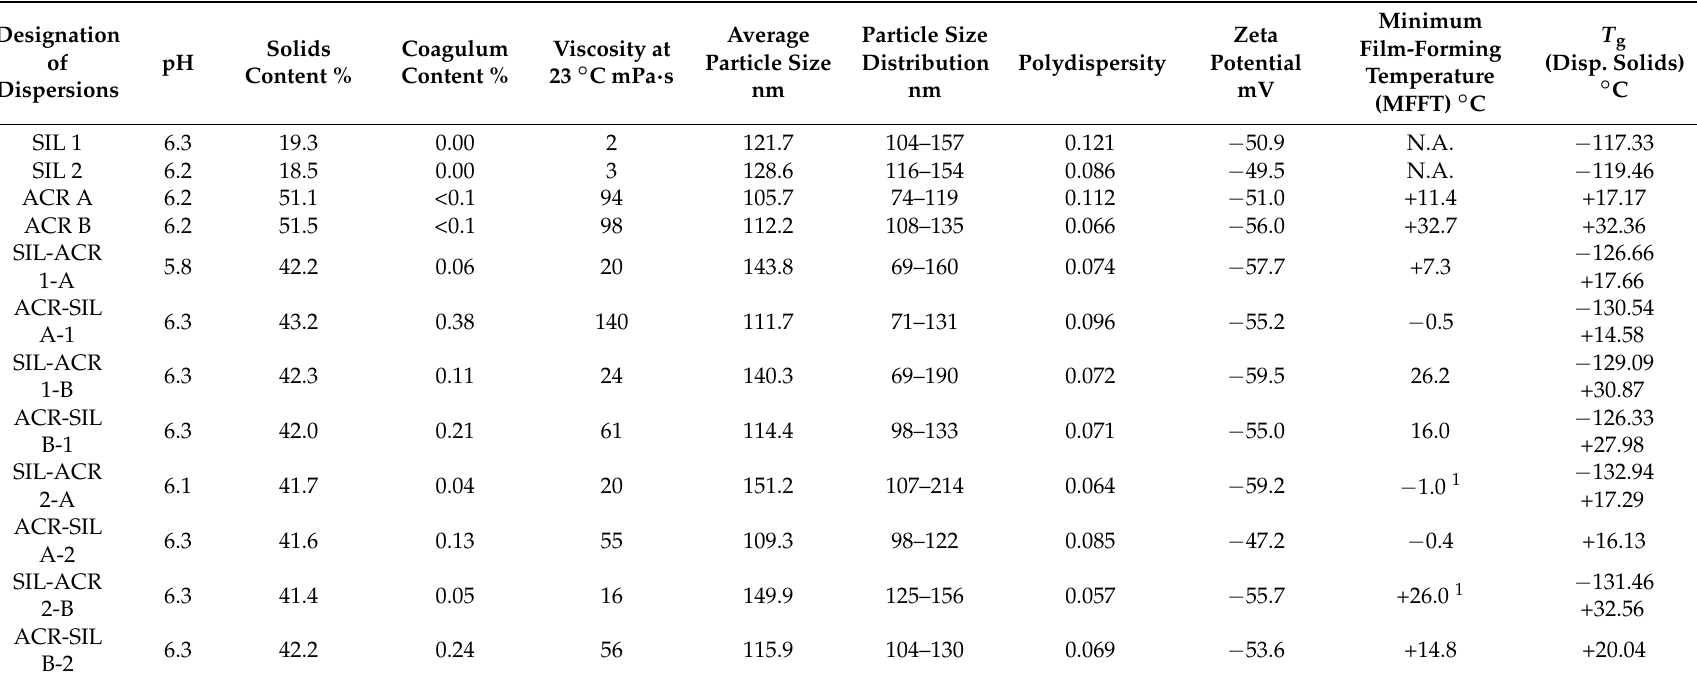
Table 1. Properties of hybrid silicone-acrylic (SIL-ACR) and ACR-SIL dispersions and of starting SIL and ACR dispersions. In the case of starting ACR dispersions all properties were determined for dispersions neutralized after polymerization while ACR dispersions before neutralization (with pH ca. 3.0) were used in synthesis